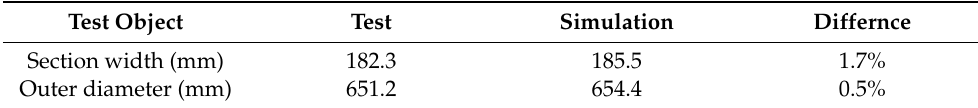
Figure 6. The aircraft tire cross-section under inflation. Table 3. Tire inflation test and simulation results.